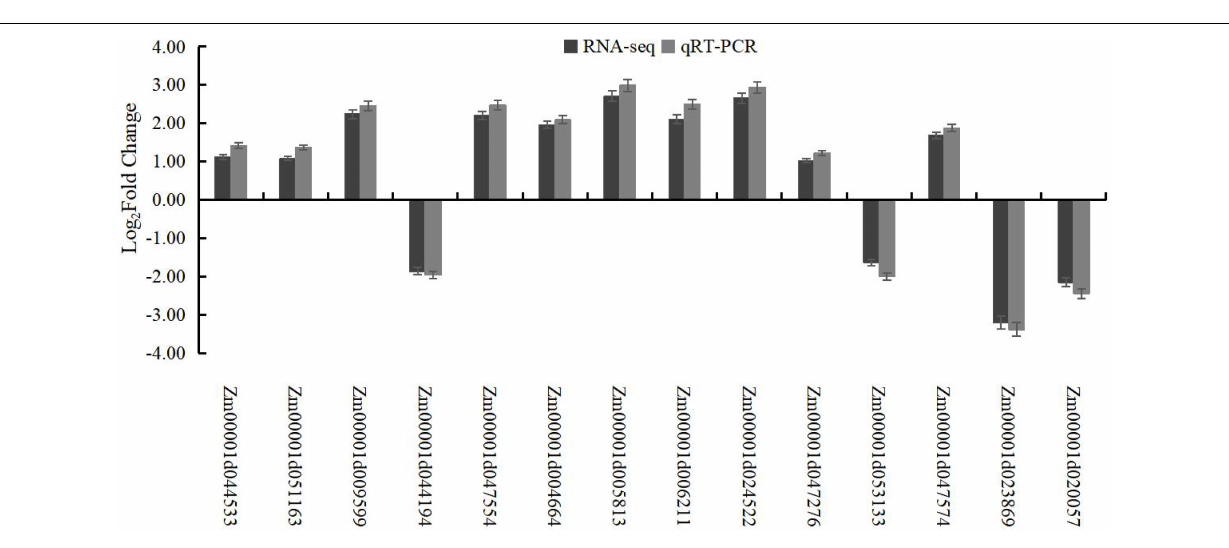
FIGURE 5 | Validation of RNA-seq expression by qRT-PCR. The actin gene (GenBank accession no. AY273142) was used as an internal